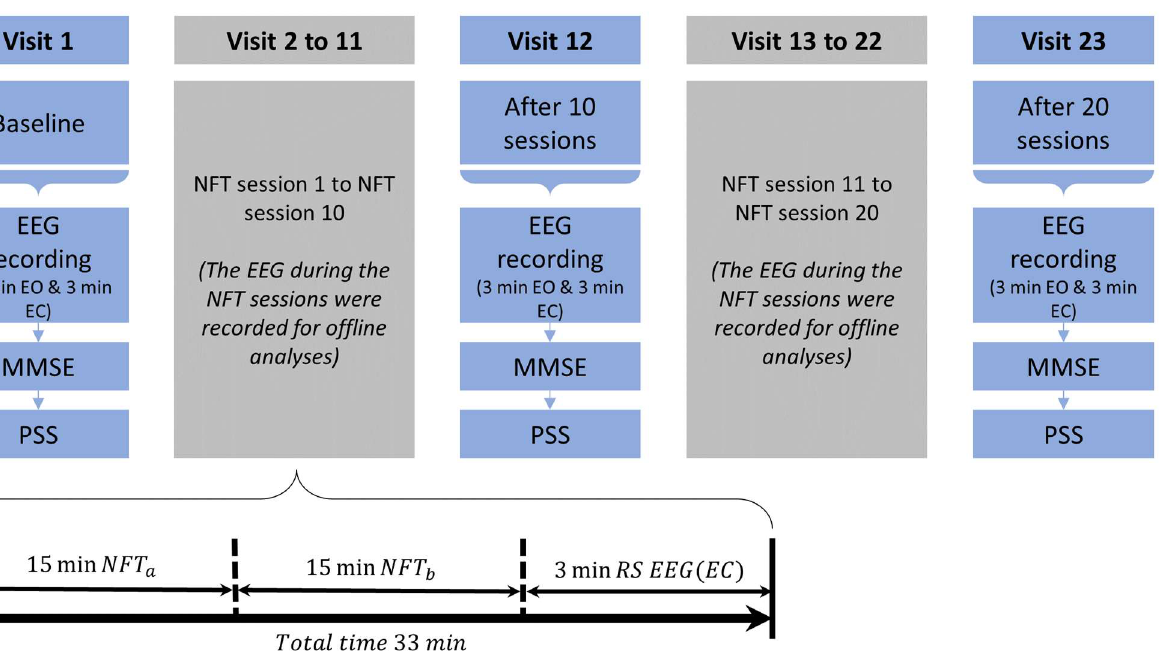
Figure 2. The flow of sessions and recording of RS–EEG and Stroop task, MMSE, and PSS responses for the NFT group.